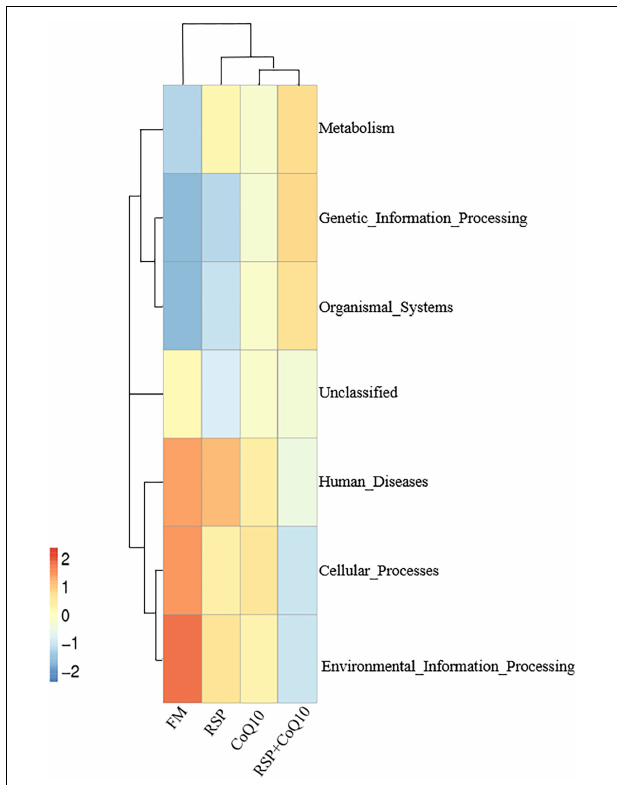
FIGURE 5 | Heat map of COG function classification of four diet treatments.